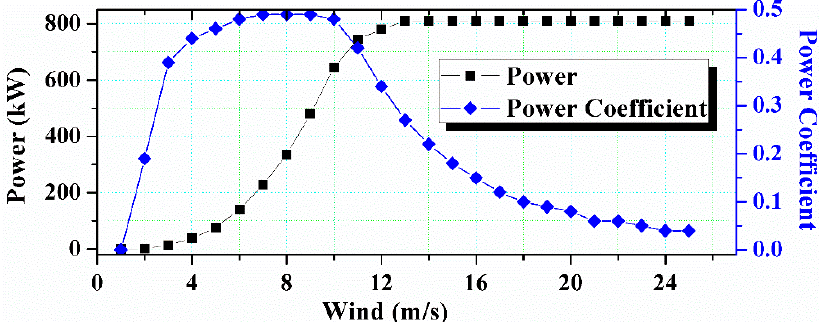
Figure 5. Characteristics of wind turbine Enercon E53 800 kW.